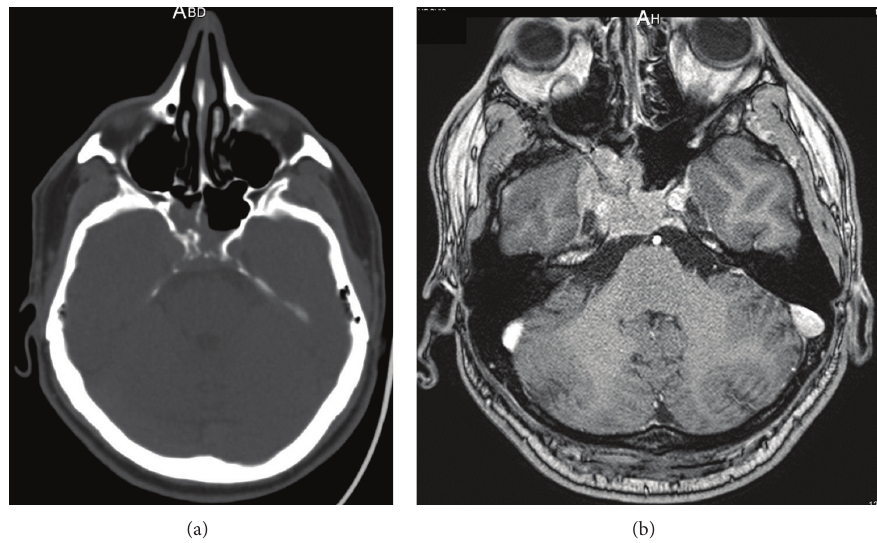
Figure 1: (a) Enlargement of the right cavernous sinus and osteolysis of the right sphenoid bone and clivus on CT scan. (b) Axial T1-weighted MRI with gadolinium contrast showing a large tumor of the skull base invading the sella turcica, right cavernous sinus, and sphenoidal sinus.